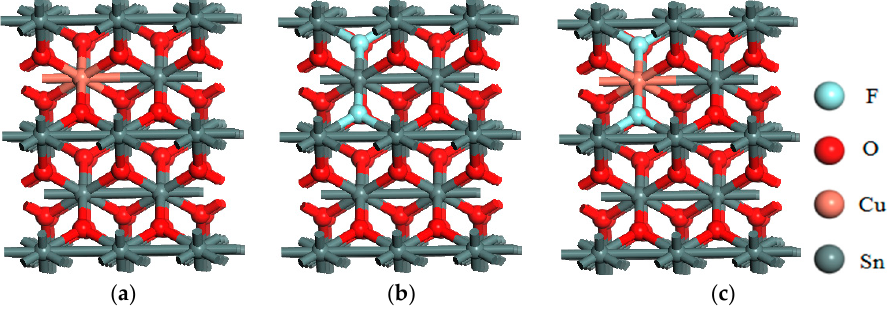
Figure 1. Doping models: ( a ) SnO 2 -Cu; ( b ) SnO 2 -F; ( c ) SnO 2 -Cu-F.